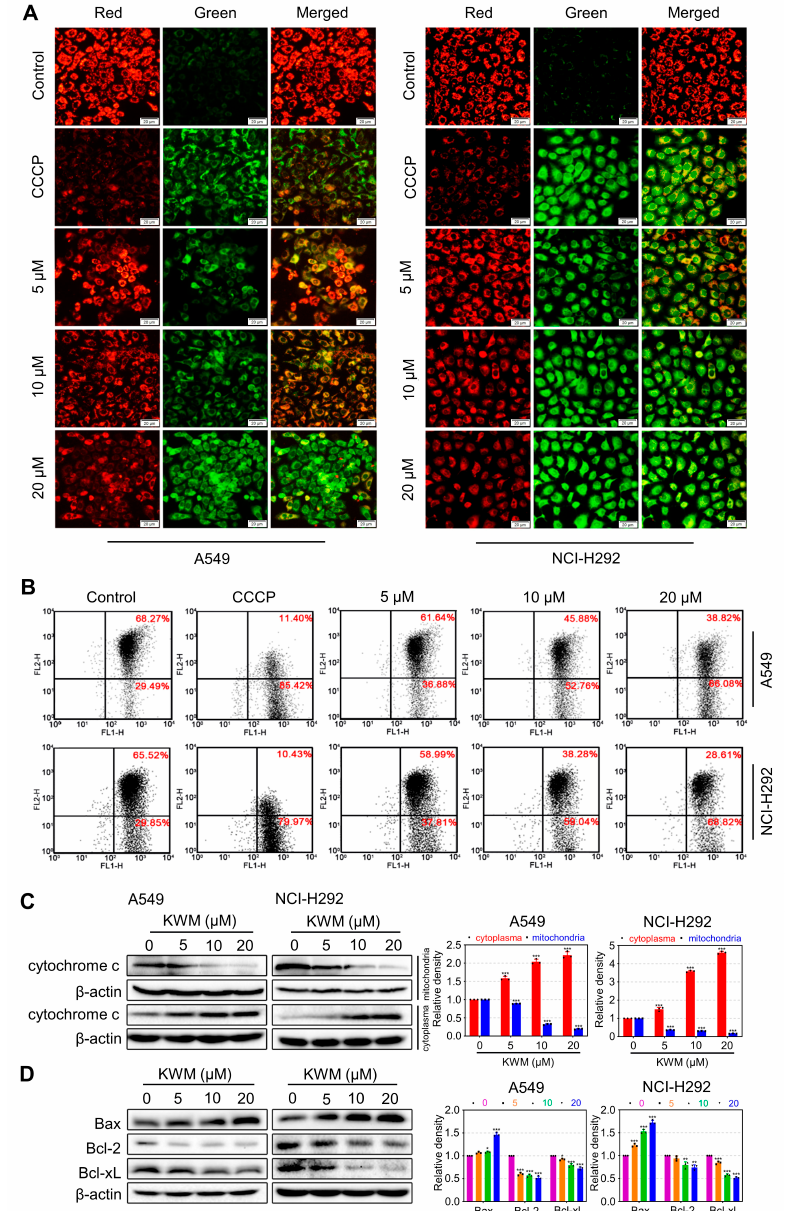
Figure 4. KWM induced apoptosis through the mitochondria-mediated intrinsic pathway in A549 and NCI-H292 cells. ( A ) Cells were incubated with KWM for 24 h. MMP changes were monitored by loading with JC-1 and detected by fluorescence microscopy. ( B ) MMP changes were analyzed by flow cytometry. ( C ) The cytosolic extracts and mitochondrial fraction were analyzed by immunoblotting to detected mitochondrial cytochrome c release. ( D ) Cells were incubated with KWM for 24 h, cell lysates were subjected to immunoblotting for Bax, Bcl-2 and Bcl-xL. β -actin was used as a loading control. Values were expressed as mean ± SD, n = 3. * p < 0.05, ** p < 0.01, and *** p < 0.001 versus control groups.